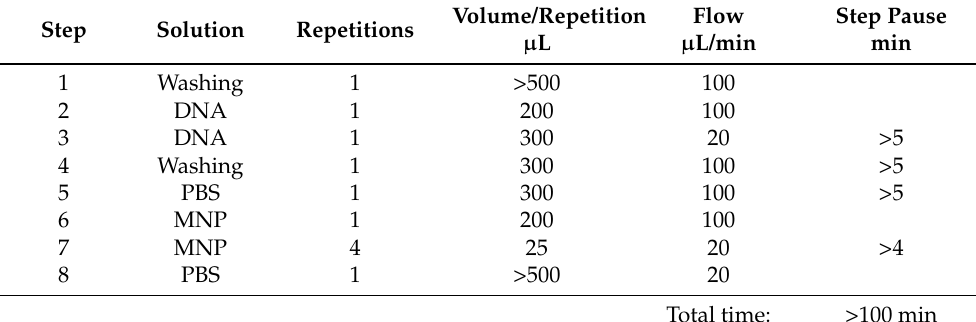
Table 4. DNA and magnetic nanoparticles hybridization